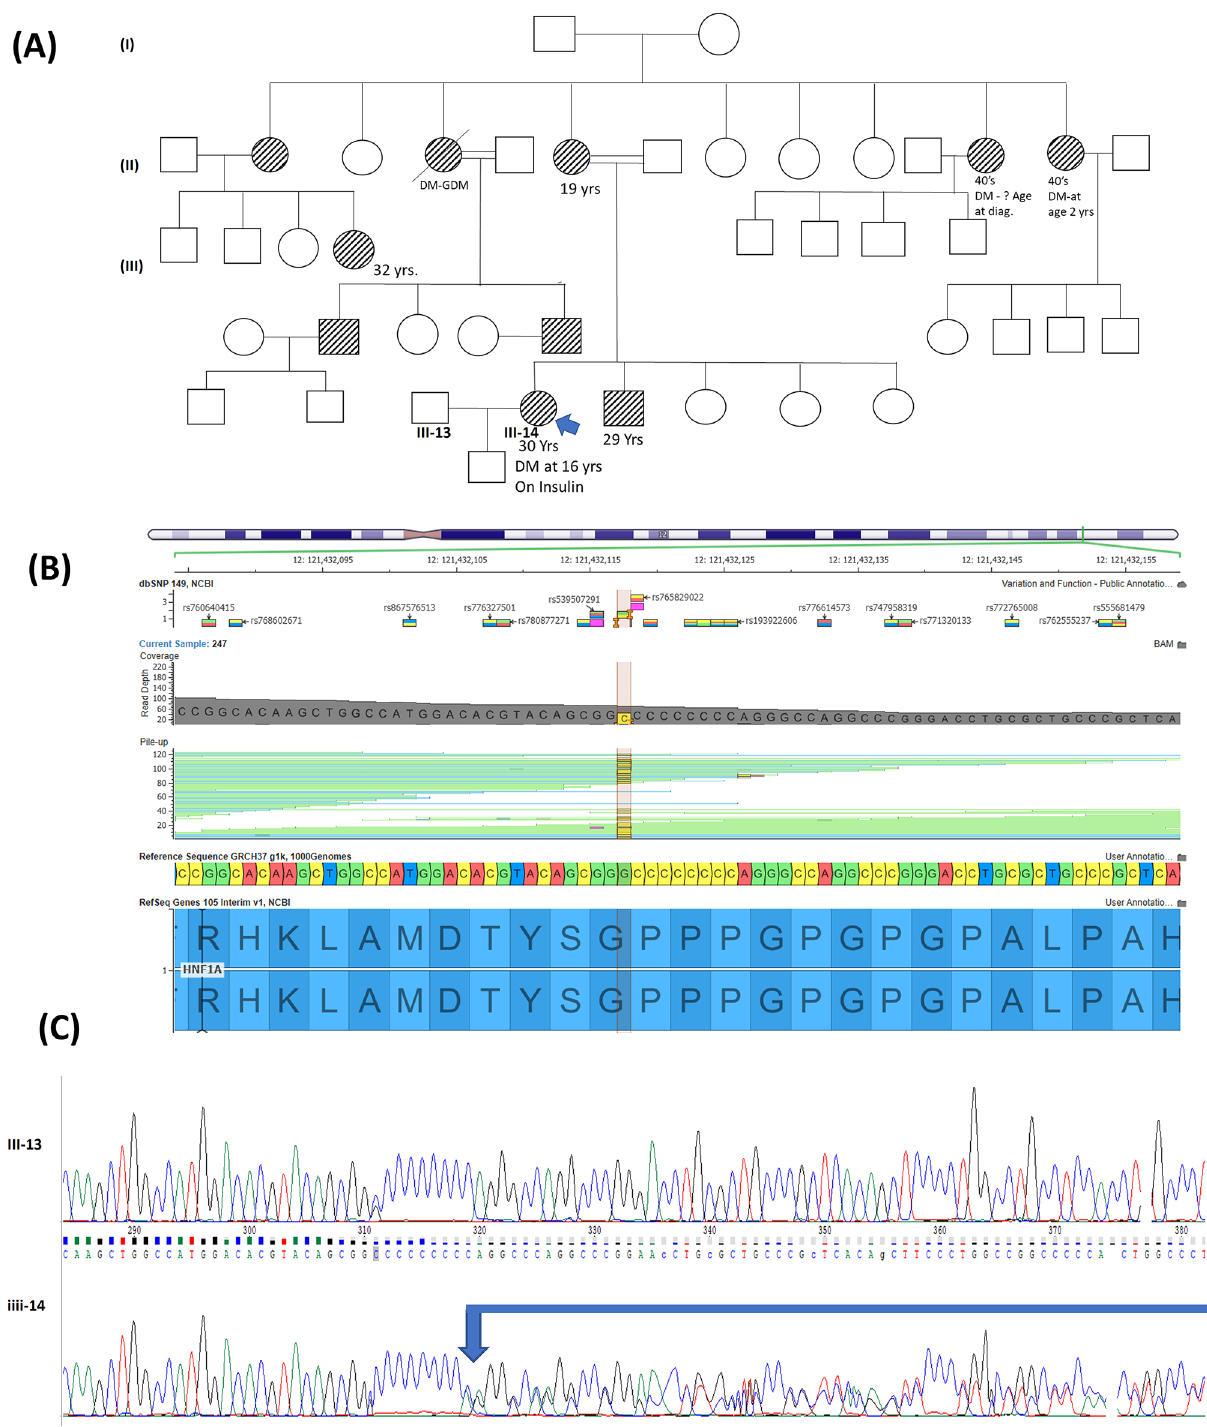
Figure 2. ( A ) Represents pedigree of a family positive for Maturity Onset Diabetes of the Young (MODY3). The square symbol represents male, and the circle represents female. The filled in symbols indicate affected individuals and the blue arrow indicates the index case. ( B ) Exome sequencing summary layout depicting part of the HNF1A gene location on chromosome 12 at the top and the exons coverage in green and blue. The location of the c.872dupC, (p.Gly292fs) frameshift mutation is represented by a vertical yellow bar and the reference sequence and the altered codon is highlighted. ( C ) Chromatogram represents Sanger sequencing of the HNF1A gene in control family member (top) and confirming the heterozygous frameshift mutation in the index (bottom